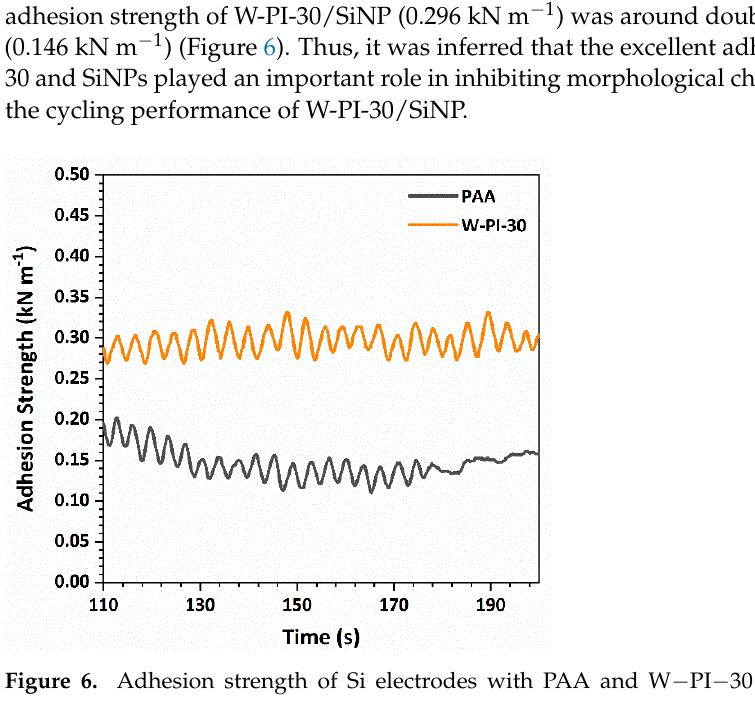
Figure 5. FE-SEM images of Si electrodes with PAA and W-PI-30 binders. ( a – f ) Surface morphology